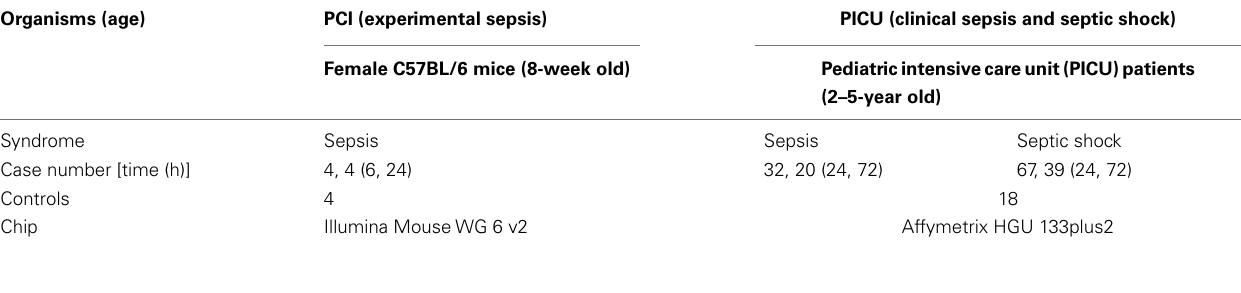
Table 1 | Characteristics of transcriptomic data used in this analysis. Organisms (age) PCI (experimental